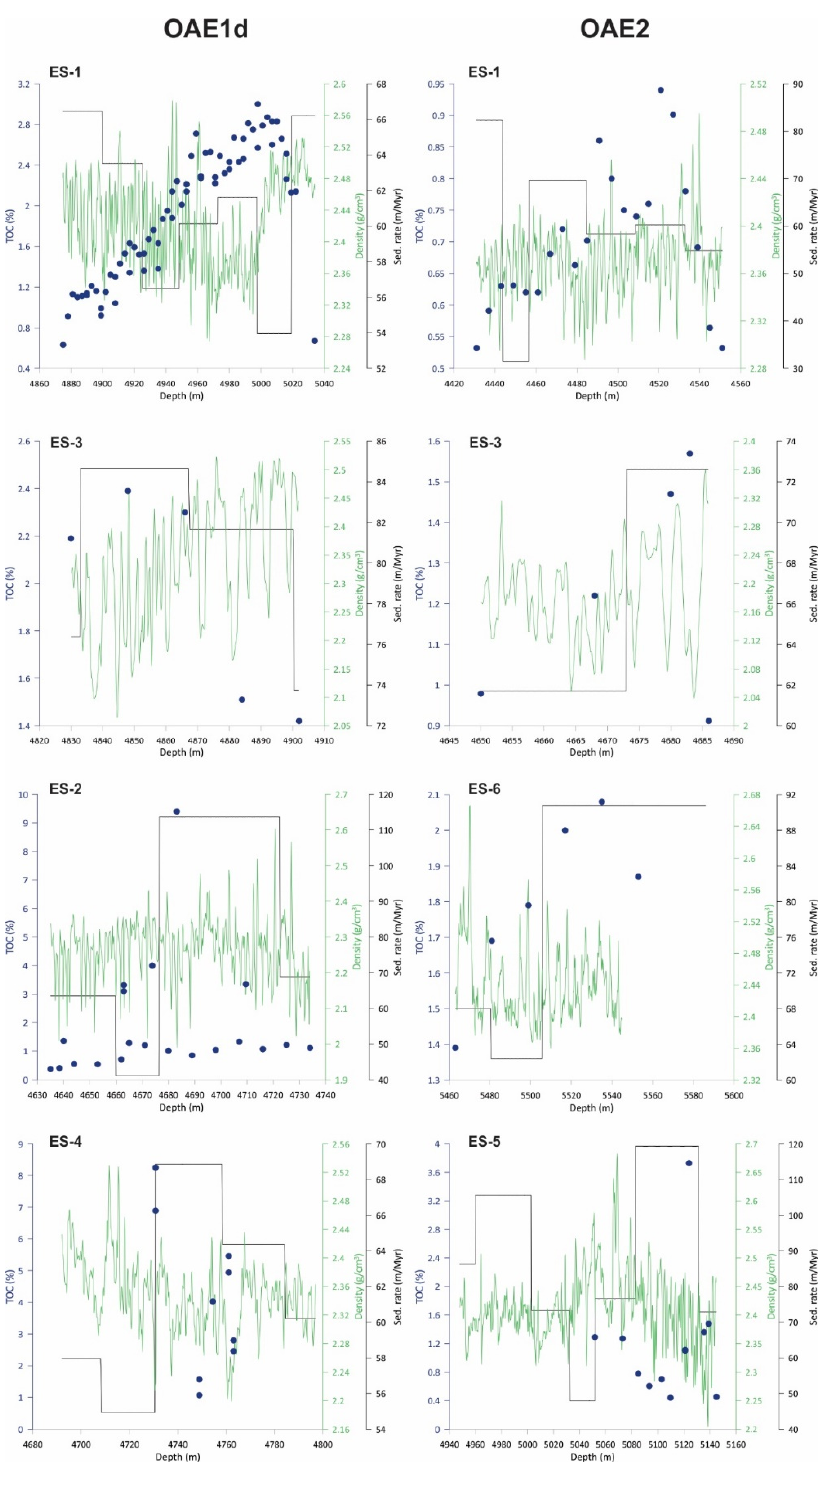
Figure 3. Results of total organic carbon (TOC, %), density (g/cm 3 ), and sedimentation rates (m/Myr) for the wells (ES-1 to 6) located in the Espírito Santo Basin during OAE1d and OAE2. TOC values are shown as blue circles, density values are shown as green lines, and sedimentation rates are shown as black